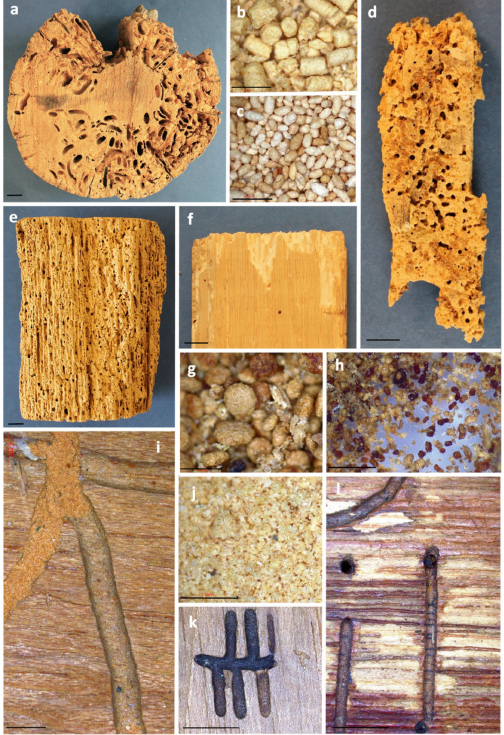
Figure 3. Galleries, exit holes, and dust excrements of several widespread wood-deteriorating beetles in Europe. ( a ) Cross-section of a utility pole with oval galleries bored by Hylotrupes bajulus (Cerambyci- dae). Note that galleries are present in sapwood only. Bar = 10 mm. ( b ) Cylindrical dust excrements characteristic of Cerambycidae. Bar = 1 mm. ( c ) Dust excrements of Anobium punctatum (Anobiidae). Bar = 1 mm. ( d ) Piece of a wooden pillar attacked by members of Curculioninae (Curculionidae). Bar = 10 mm. ( e ) Piece of wood heavily attacked by members of Anobiidae. Bar = 10 mm. ( f ) Piece of a skirting board attacked by members of Lyctinae (Bostrichidae). Note the presence of longitu- dinal galleries covered by dust. Bar = 10 mm. ( g ) Dust excrements of Xestobium rufovillosum (Anobiidae). Bar = 1 mm. ( h ) Dust excrements characteristic of Curculioninae (Curculionidae). Bar = 500 µ m. ( i ) Detail of a larval gallery bored by members of Lyctinae (Bostrichidae) and partially filled with dust excrements, which are soft to the touch. Bar = 2 mm. ( j ) Detail of the amorphous dust excrements characteristic of Lyctinae (Bostrichidae). Bar = 1 mm. ( k , l ) Galleries and exit holes bored by members